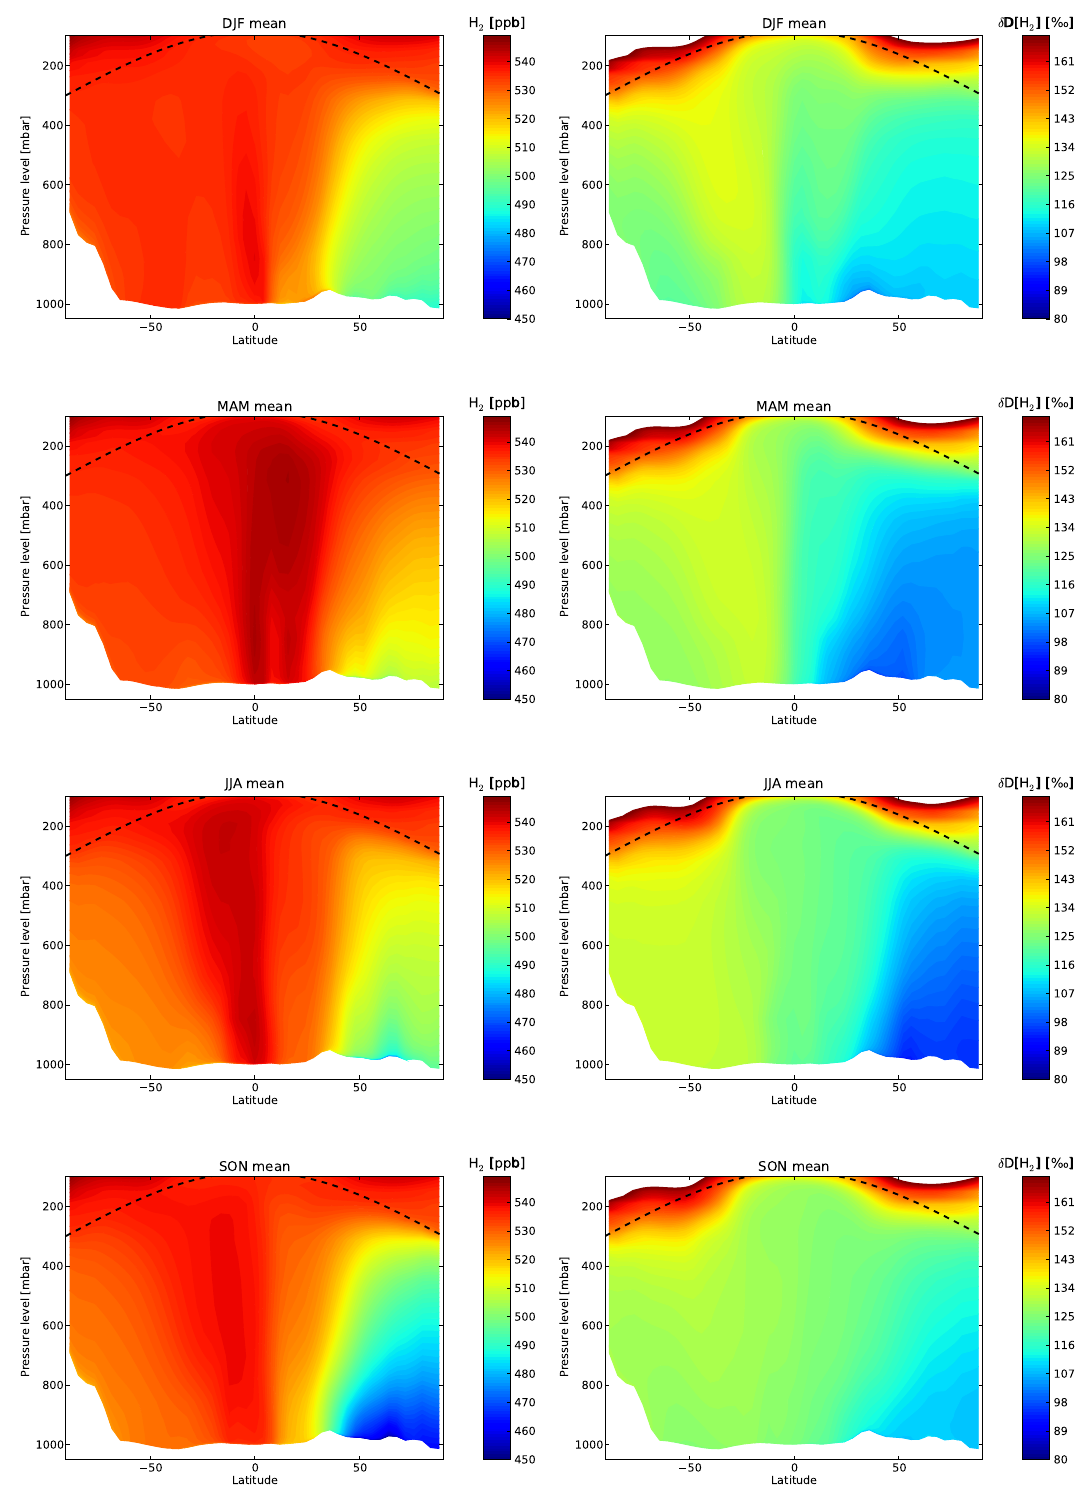
Fig. 5. Seasonal zonal mean H 2 mixing ratio in ppb (left column) and isotopic composition in ‰ (right column) during the NH winter (DJF), spring (MAM), summer (JJA), and autumn (SON) season. The reference tropospheric boundary for the stratospheric parametrisation (see Sect. 2.3) is indicated by the dashed